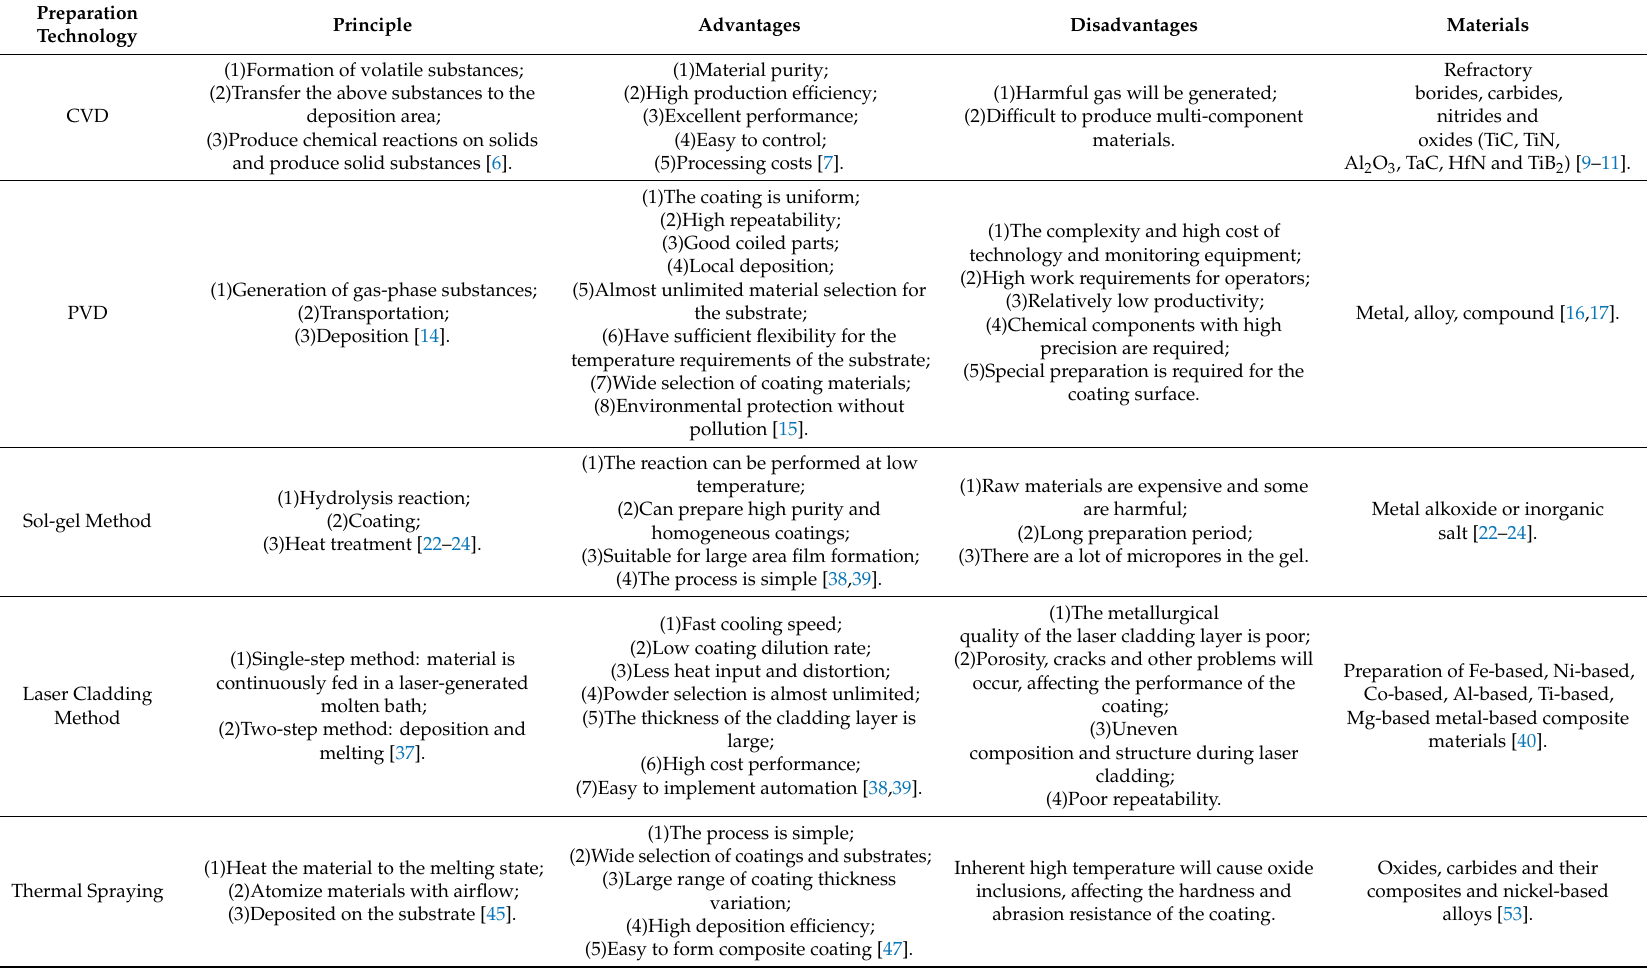
Table 1. Comparison and summary of various preparation